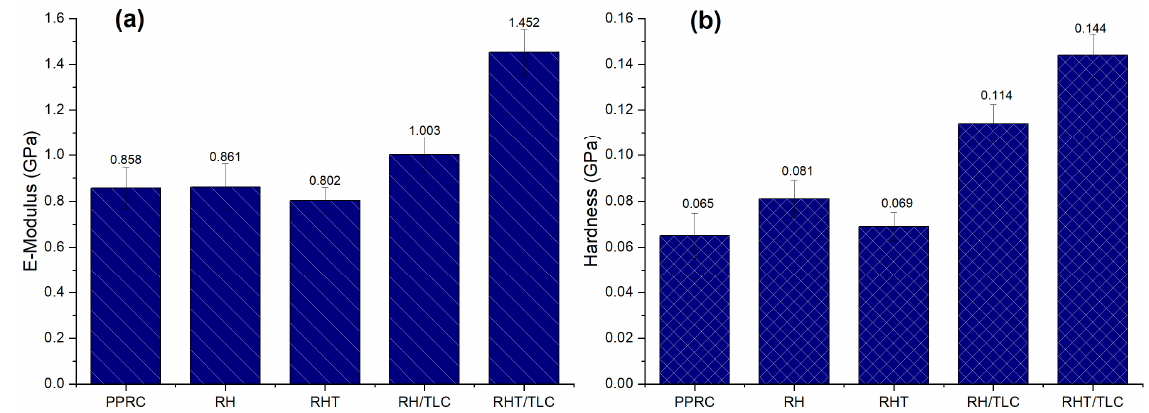
Figure 5. ( a ) Elastic modulus, E, and ( b ) hardness of different samples.